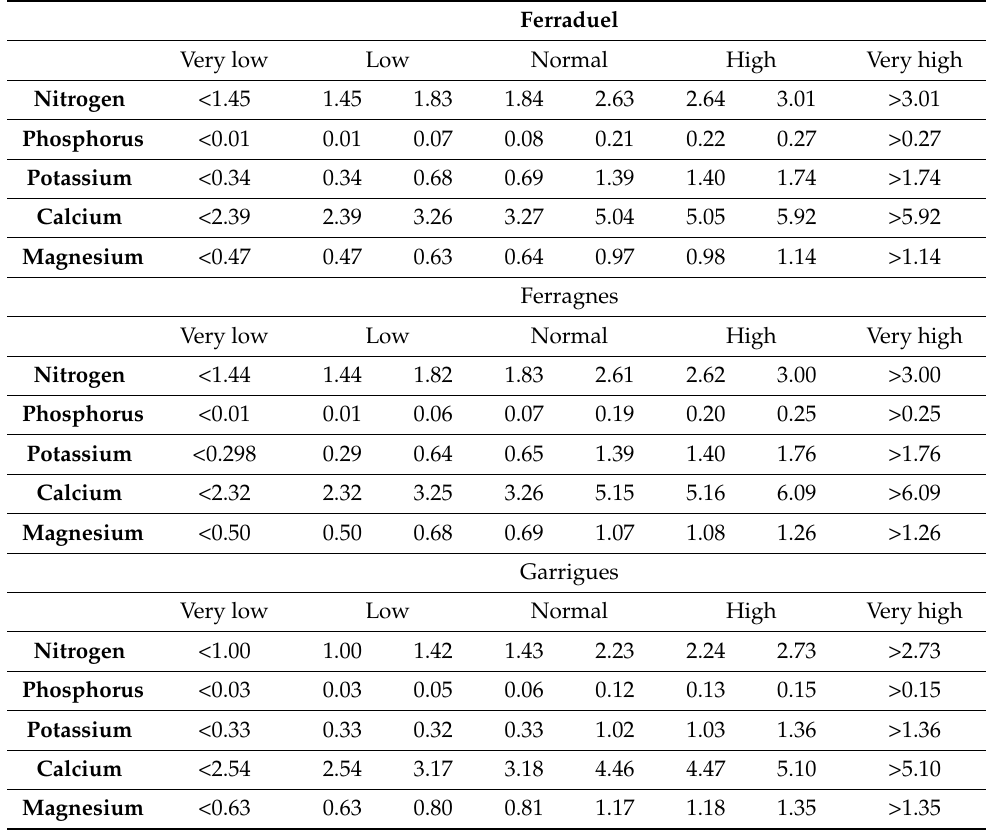
* Within each column, the mean values of the nutrient concentration with the same letter do not represent significant differences at p < 0.05. SD indicates the standard deviation of the samples, SE indicates the standard error, and CV is the coefficient of variation. n = 24. Table 2. Ranges of normality for the Ferraduel, Ferragnes, and Garrigues